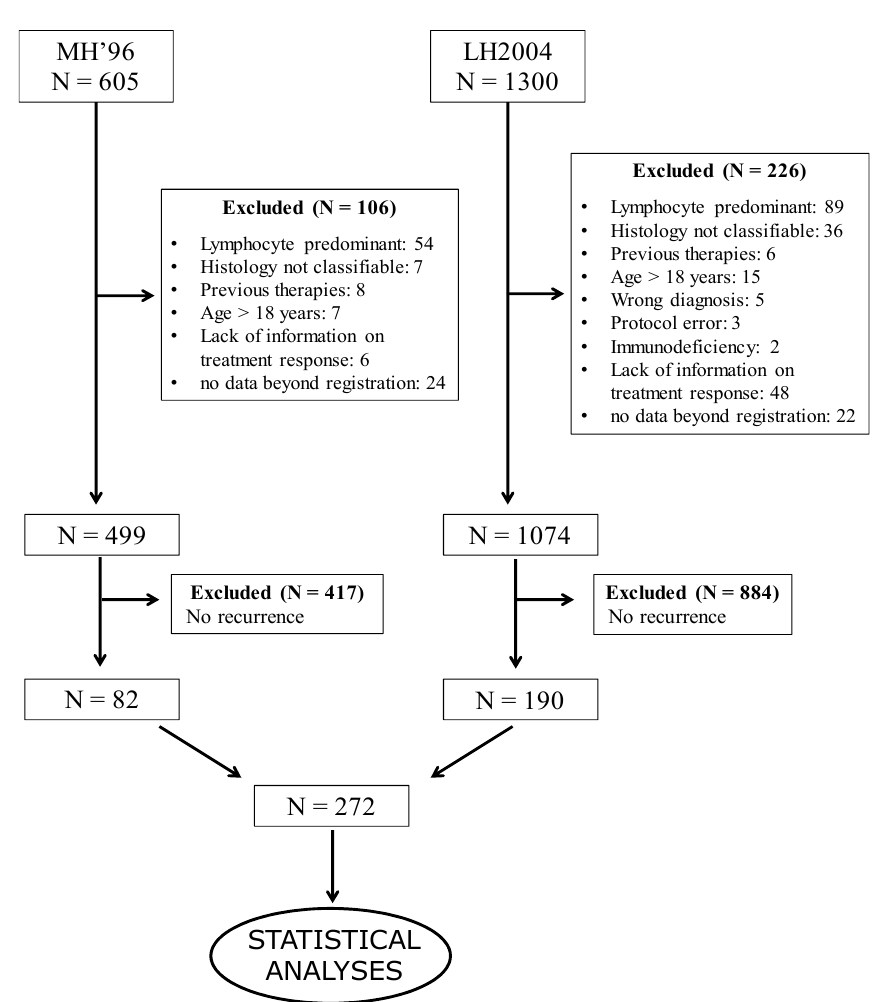
Figure 1. Patient selection for statistical analyses.